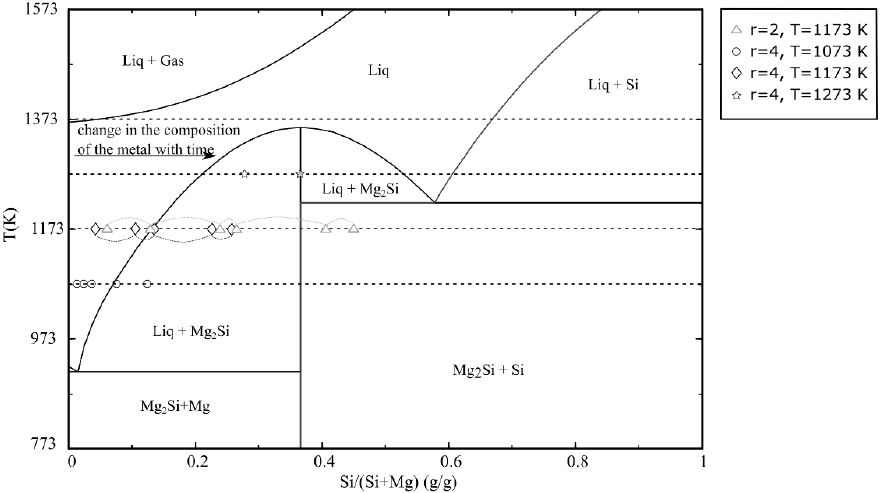
Figure 7. Binary phase diagram of Mg–Si, plotted by FactSage 8.1(r is the Mg/SiO 2 mole ratio). Table 2. Vapor pressure and number of Mg moles in the gas phase; (vapor pressure is calculated by FactSage 8.1).